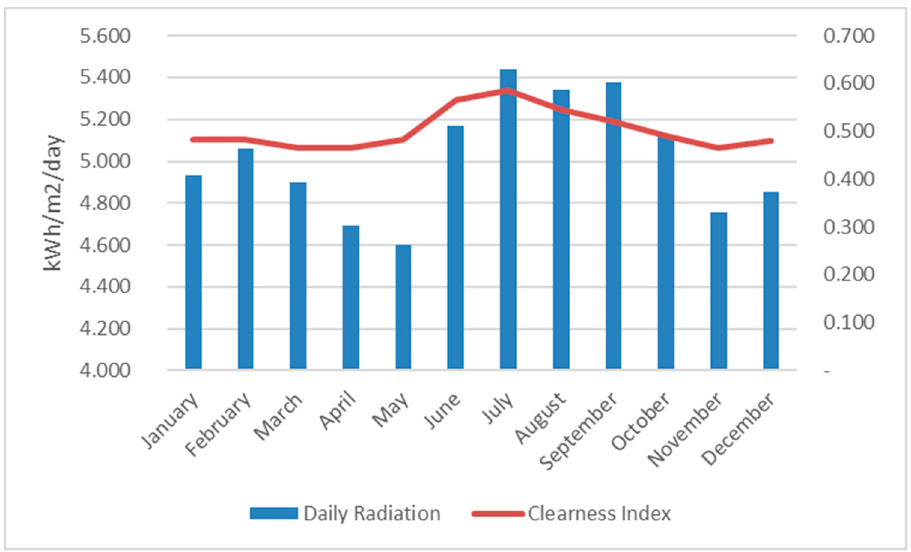
Figure 5. Assumed average daily solar irradiation and clearness index for the plant location.